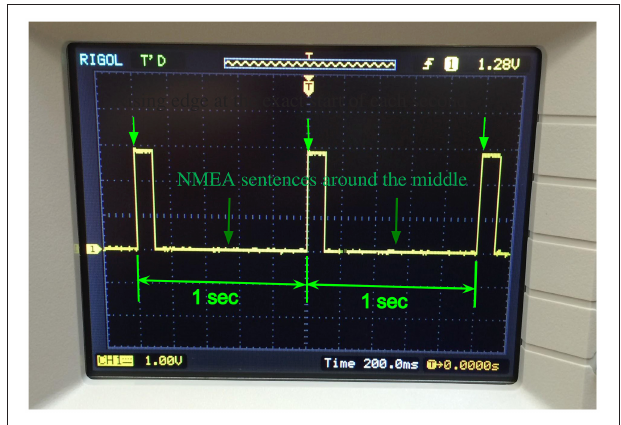
FIGURE 3 | Pulse-Per-Second (PPS) signal waveform.